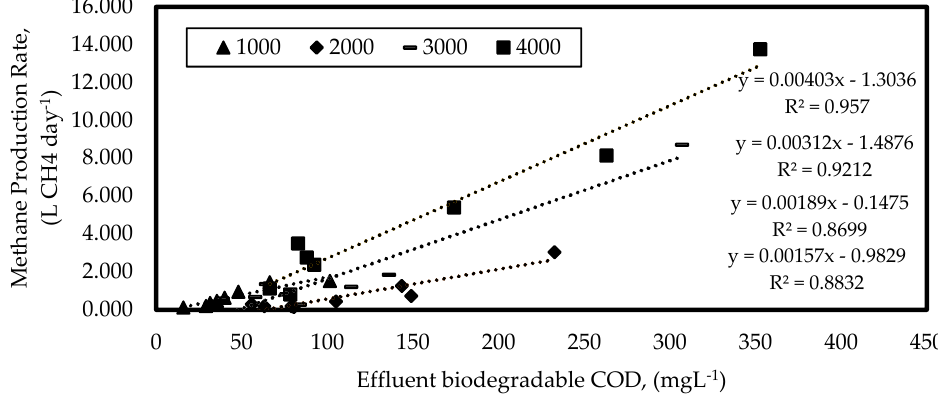
Figure 7. Variation in methane production rate as a function of effluent biodegradable substrate concentration.